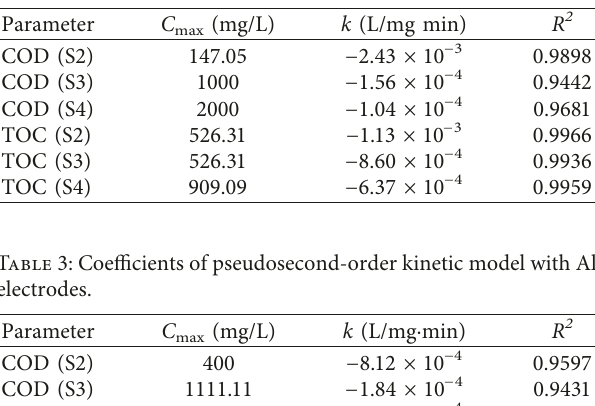
Table 2: Coefficients of pseudosecond-order kinetic model with Fe electrodes.